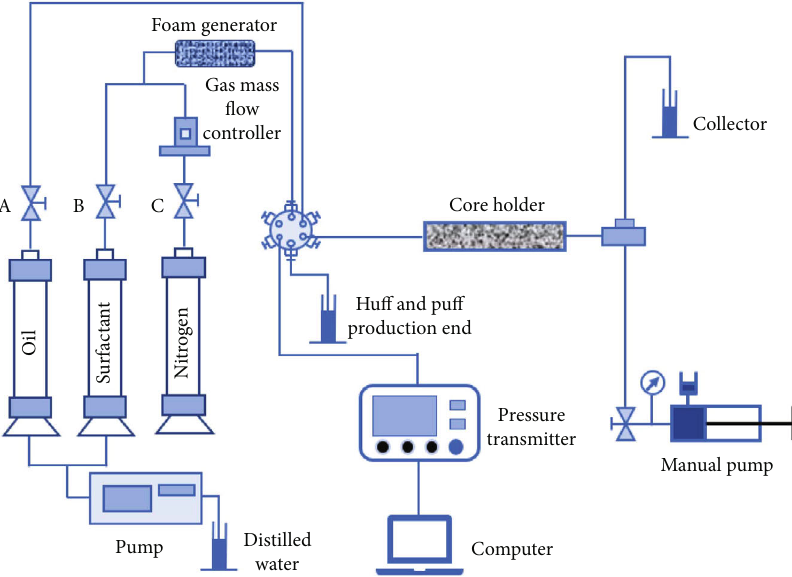
Figure 3: Schematic diagram of the one-dimensional fl ooding experimental device.